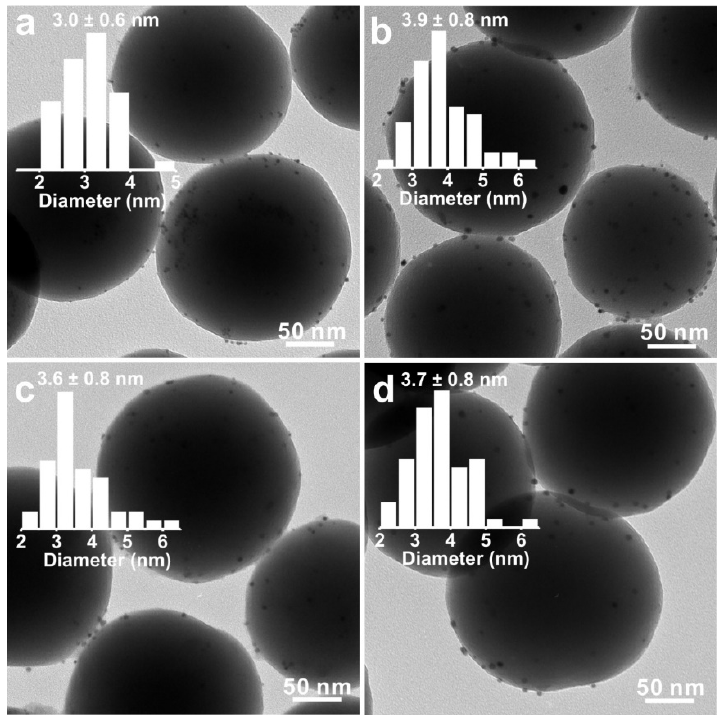
Figure 2. TEM images of Pt/SiO 2 and PtBi x /SiO 2 , ( a ) Pt/SiO 2 , ( b ) PtBi 0.05 /SiO 2 , ( c ) PtBi 0.2 /SiO 2 , ( d ) PtBi 0.3 /SiO 2 .